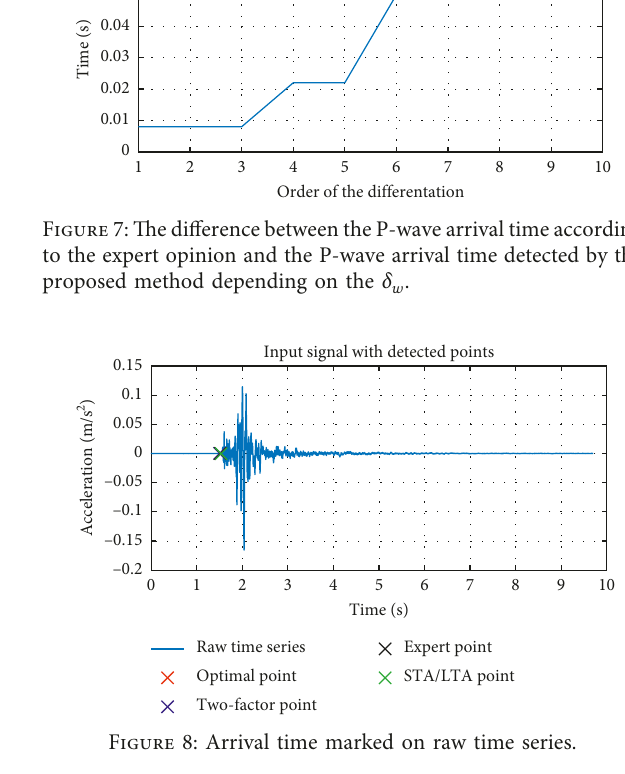
Distance from the point indicated by expert